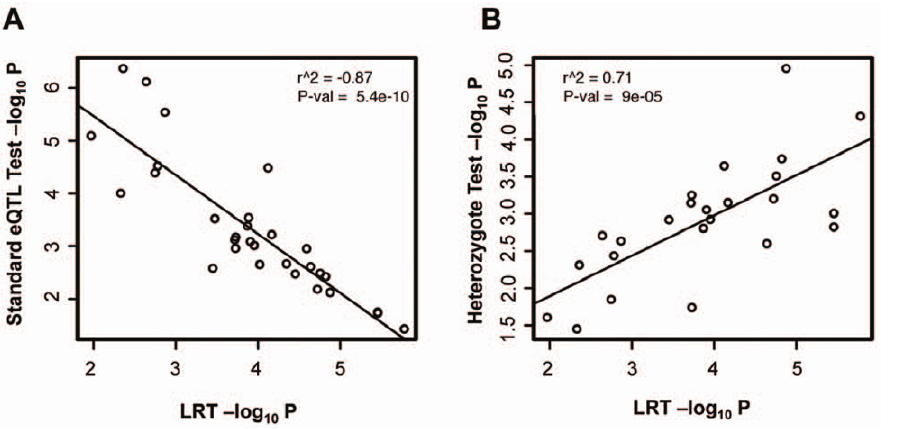
Figure 3. Comparison of separate association using maternal and paternal alleles with the Likelihood Ratio Test (LRT) for putative 30 ieQTLs. (A) Correlation between –log 10 p-values generated using a standard association test and the LRT (r 2 = 2 0.87) (B) Correlation between - log 10 p-values generated using the heterozygote test and the LRT (r 2 =0.71). Note that 6 of the 30 SNP-gene pairs did not have a sufficient number of heterozygotes to perform the test.